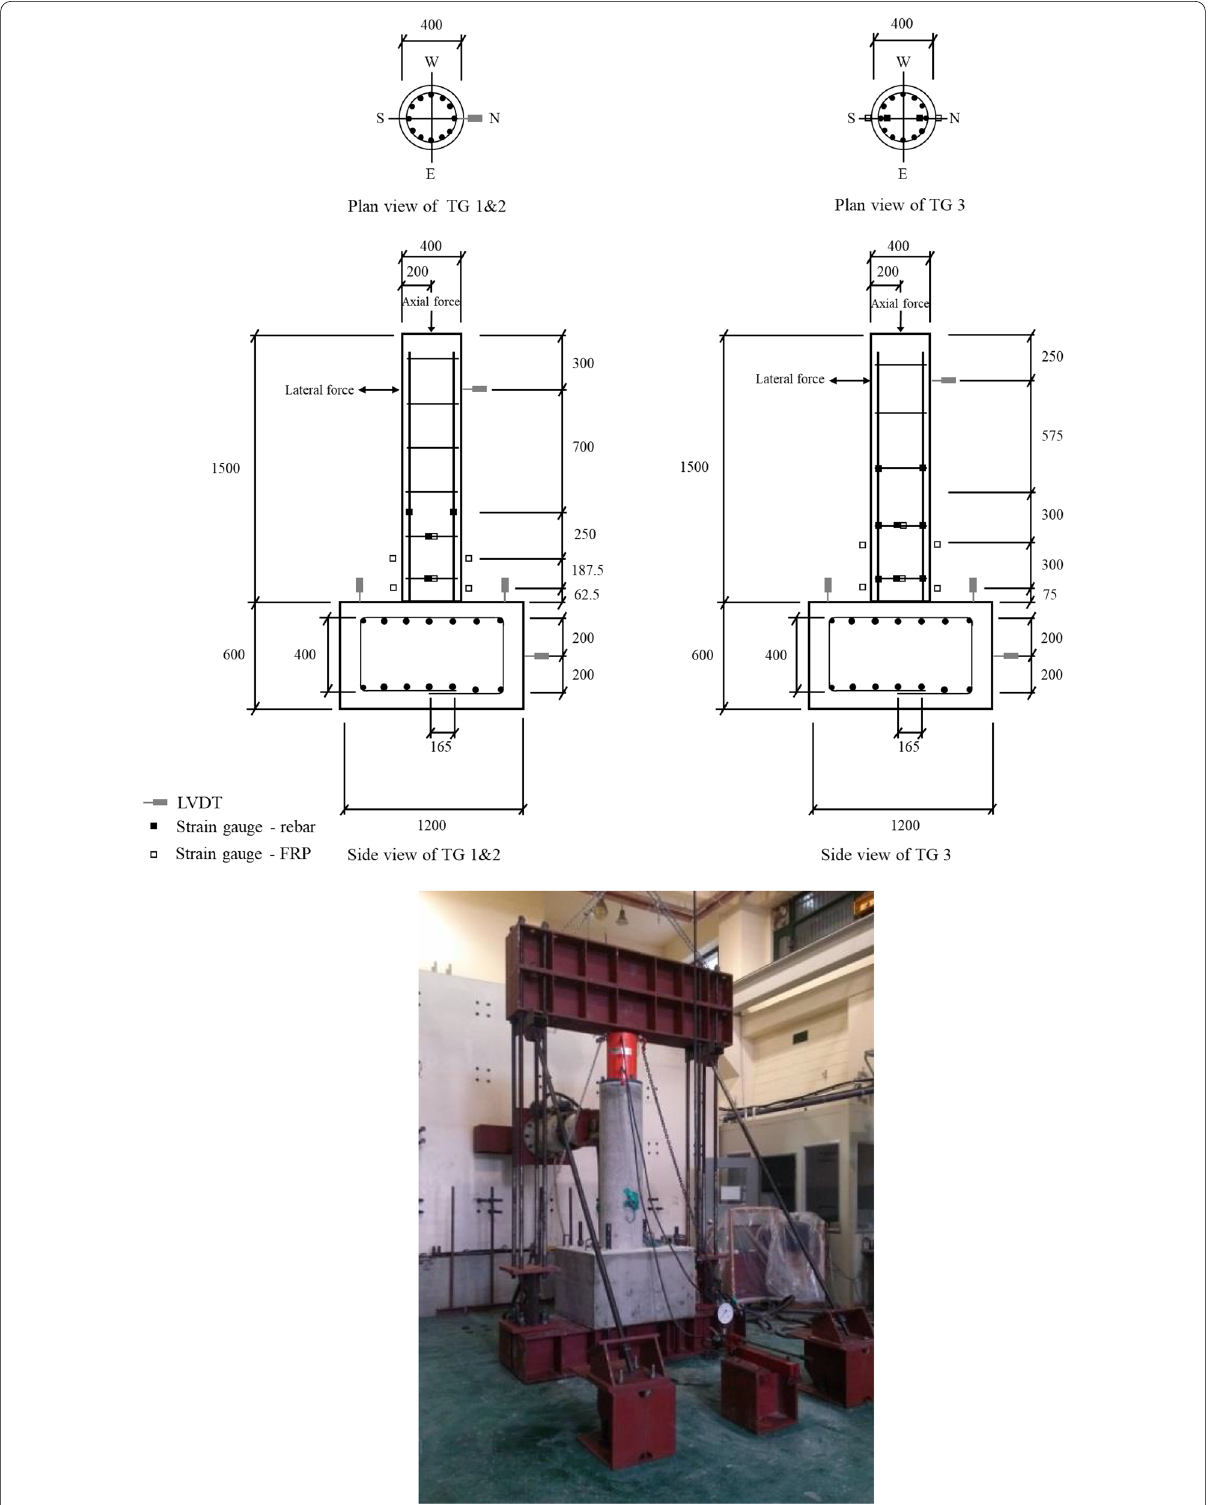
Fig. 5 Locations of vertical and horizontal loads, strain gauge, and LVDTs and a picture of setup (Note: unit is in